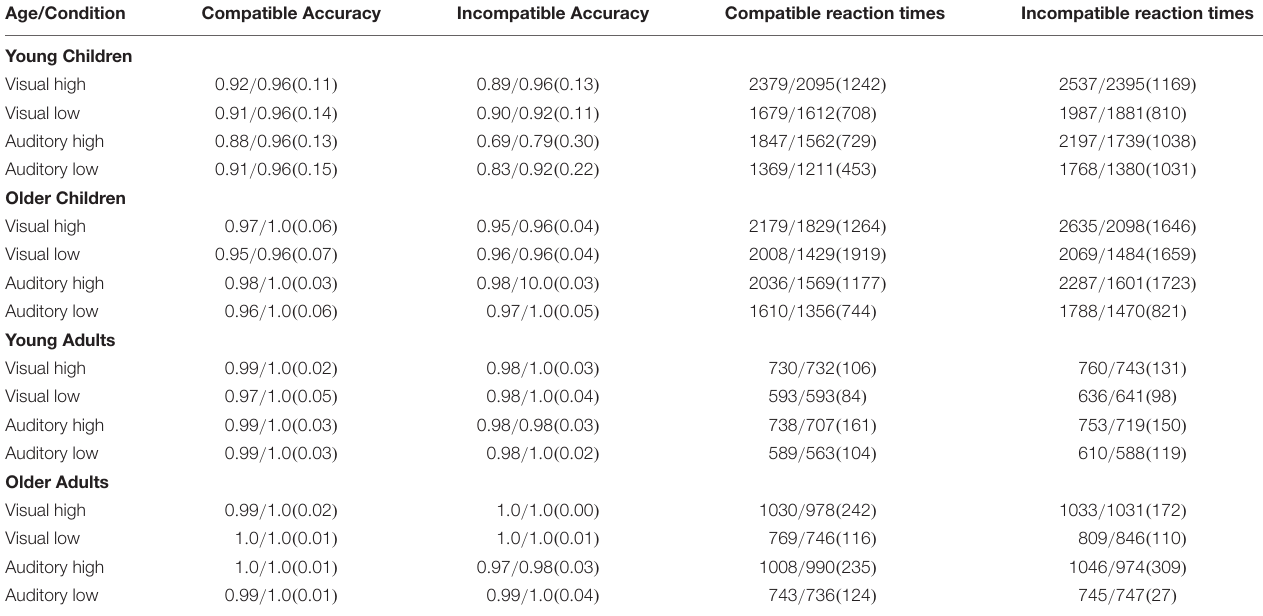
TABLE 1 | Mean/Median proportion correct, Mean/Median response times in ms, and (Standard Deviations) across age, distractor modality, and